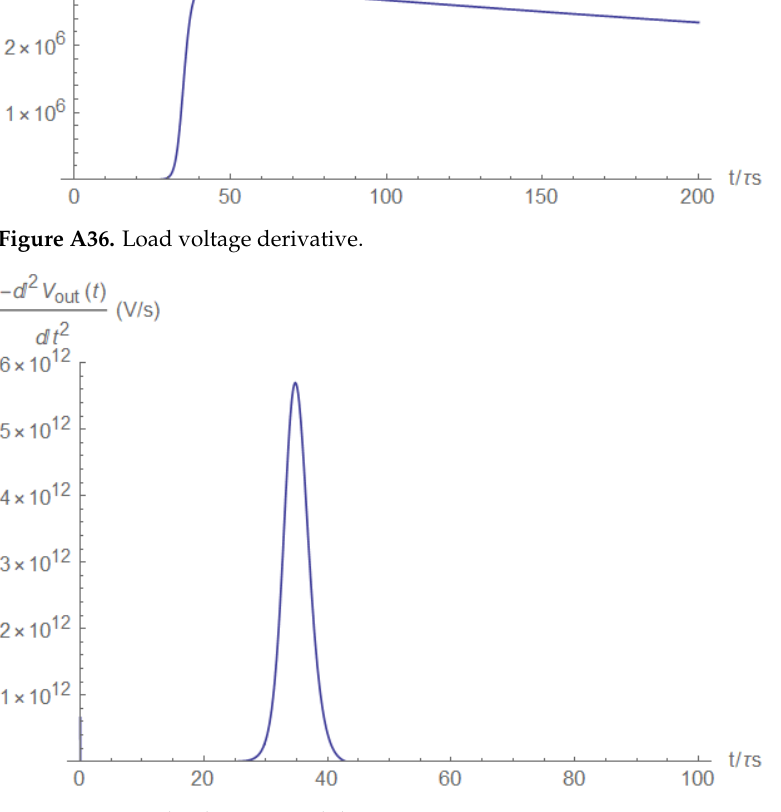
Figure A37. Load voltage second